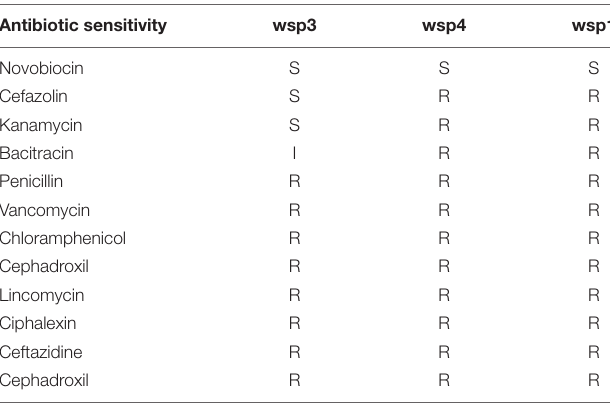
TABLE 2 | Antibiotic susceptibility test of the